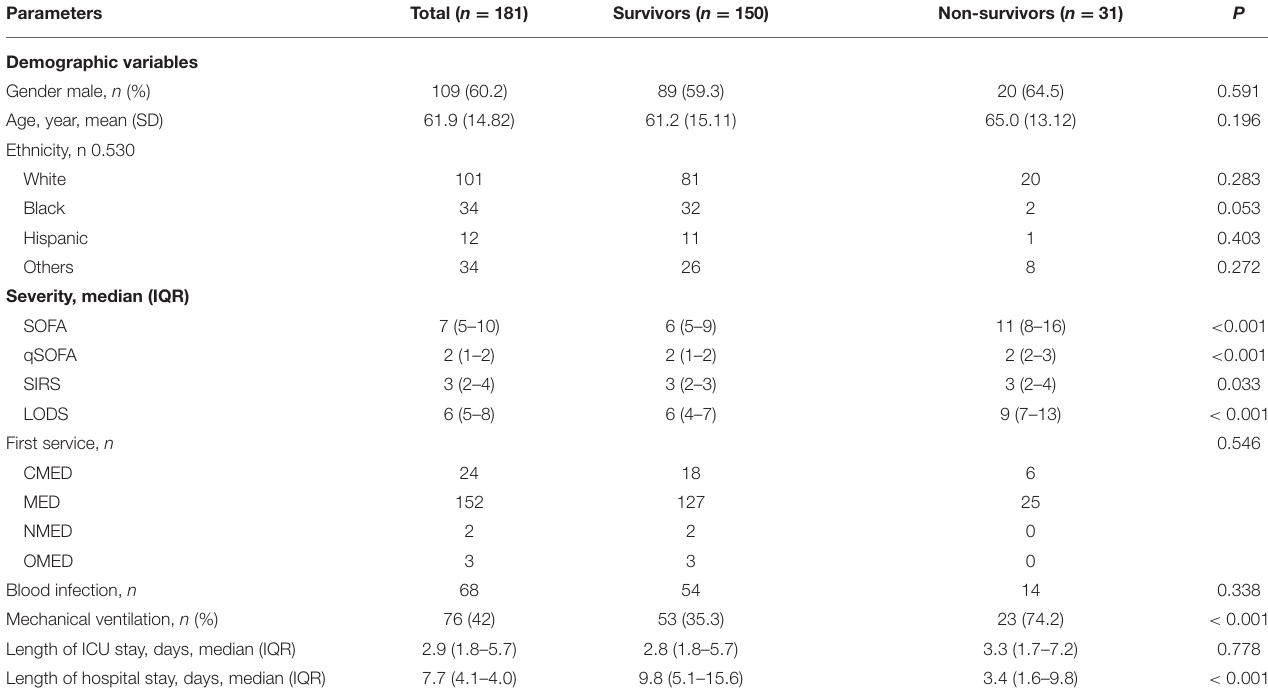
TABLE 1 | Baseline characteristics in patients with sepsis who received CRRT.